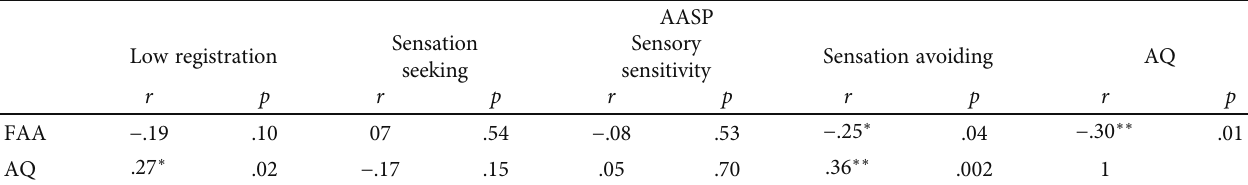
Table 2: Correlations between AASP quadrants, FAA, and the AQ.